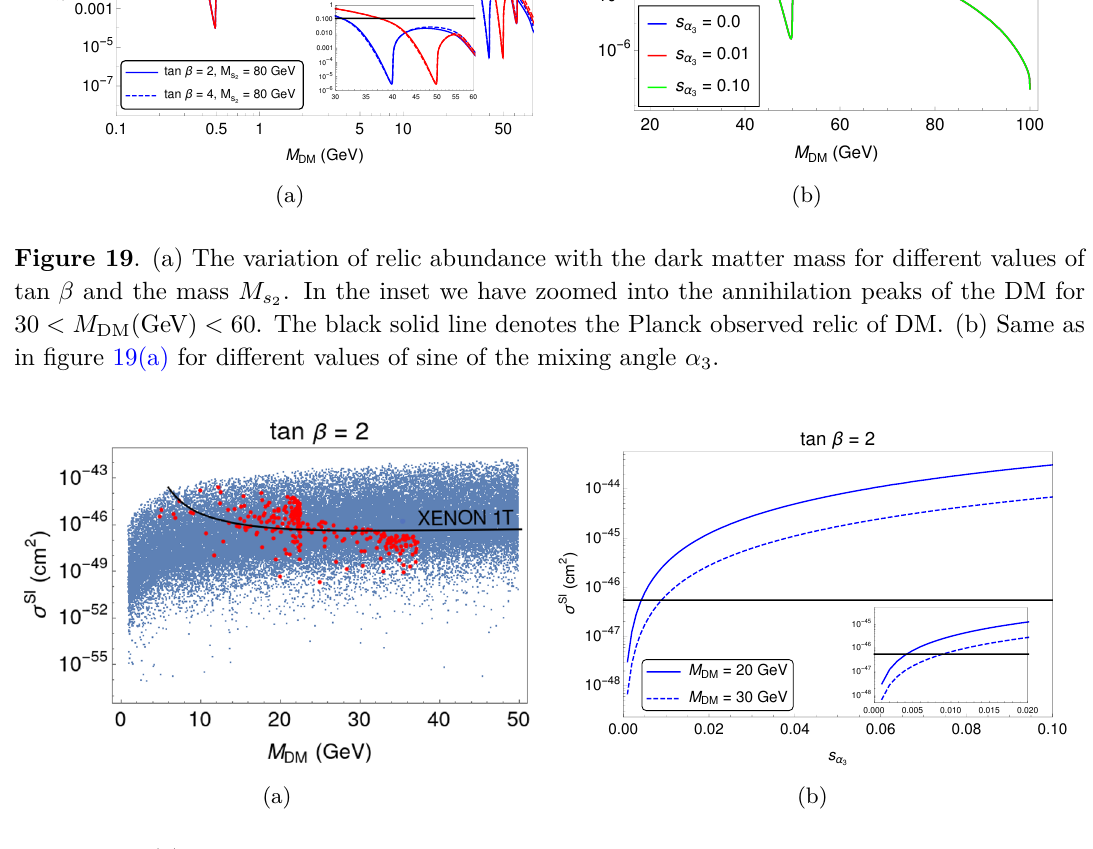
for different allowed values of M DM 3